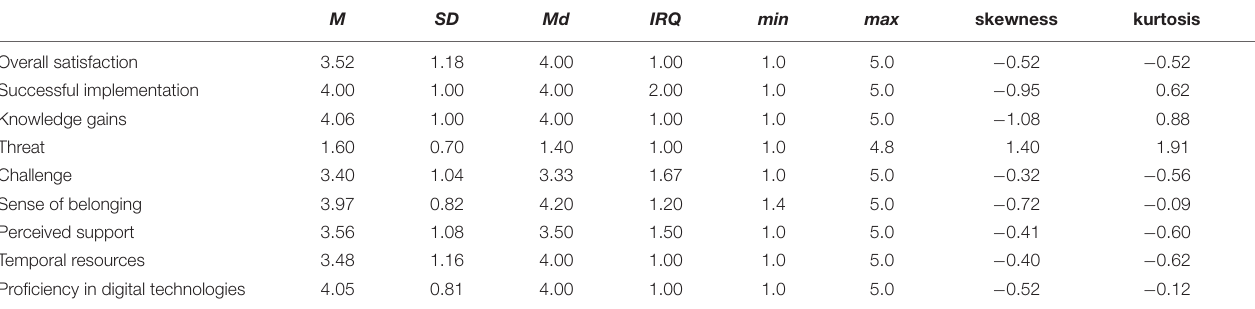
TABLE 1 | Descriptive statistics ( M , SD , MD , IRQ , min , max ), skewness, kurtosis.